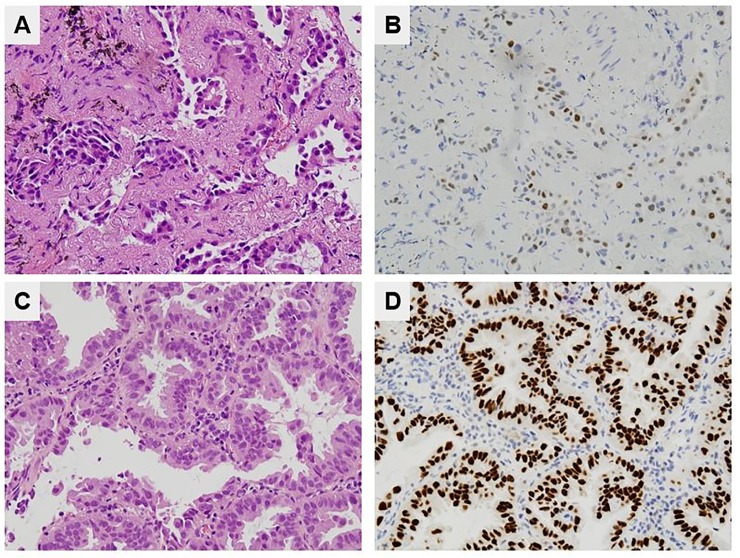
Comparison of an EBUS-GS specimen yielding false-negative EGFR results and a specimen yielding correct EGFR results.(A) A few adenocarcinoma cells were clustered in the EBUS-GS specimen with the false-negative EGFR result (H&E stain, ×400). (B) The EBUS-GS specimen with false-negative EGFR result was weakly immunoactive for TTF-1 (×400). (C) Larger numbers of tumor cells were evident in the specimen yielding correct EGFR results (H&E stain, ×400). (D) The EBUS-GS specimen with correct EGFR result was strongly immunoactive for TTF-1(×400). EBUS-GS = endobronchial ultrasound using a guide sheath; EGFR = epidermal growth factor receptor; TTF-1 = thyroid transcription factor-1.